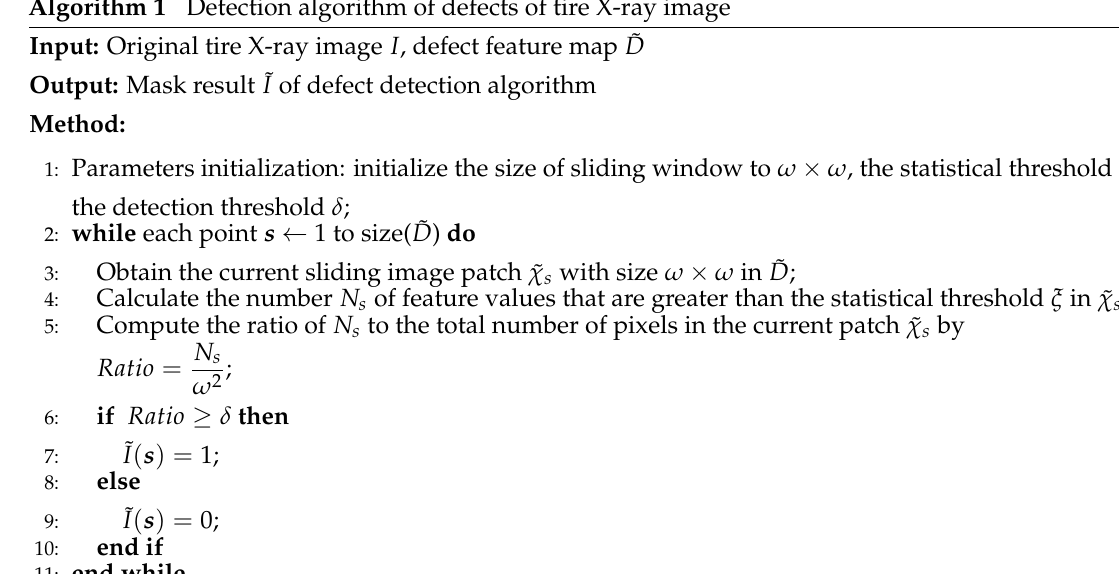
Algorithm 1 Detection algorithm of defects of tire X-ray